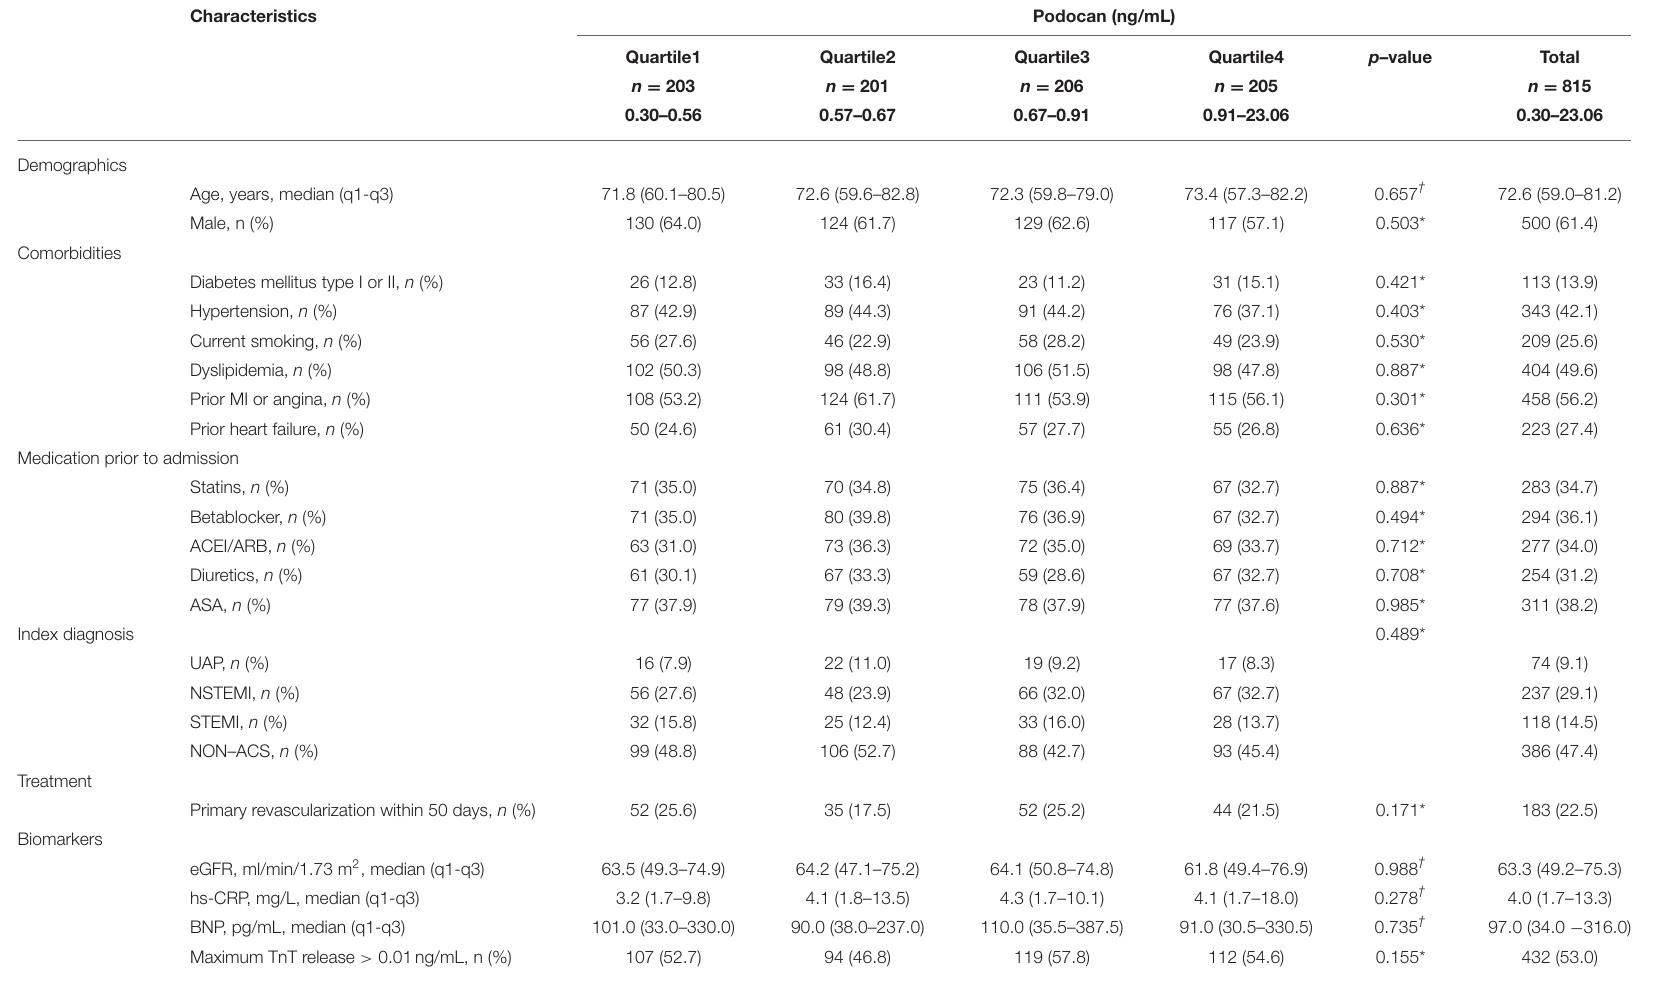
TABLE 1 | Baseline characteristics of the study